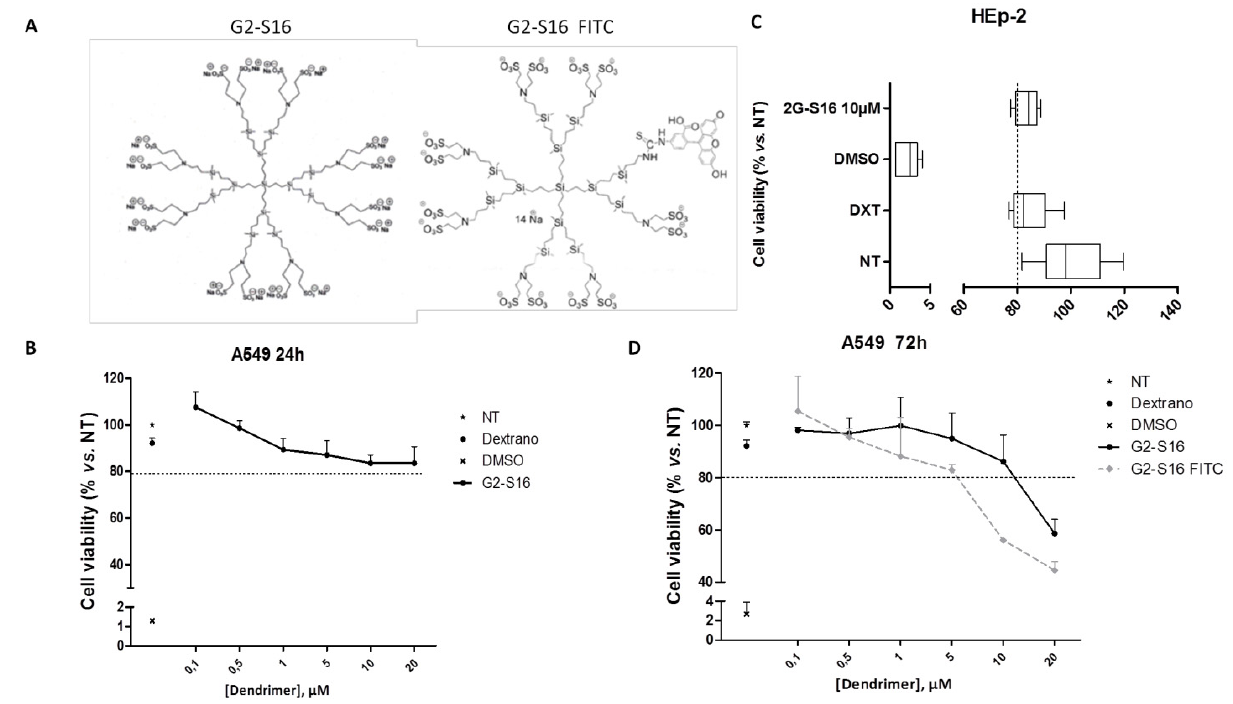
Figure 1. ( A ) Schematic representation of G2-S16 and G2-S16-FITC dendrimers. ( B – D ) Viability of A549 cells was evaluated by MTT assay after 24 h ( B ), 72 h ( D ), or 5 days of exposure ( C ) in HEp-2 cells to a range of G2-S16 dendrimer concentrations; 80% of viability was set as the limit of toxicity for the G2-S16 dendrimer. Dextran 20 µM and DMSO 10% were used as controls. Data were represented as mean ± standard deviation of three independent experiments by triplicate. NT = non-treated control; DXT = dextran; DMSO = dimethyl sulfoxide.